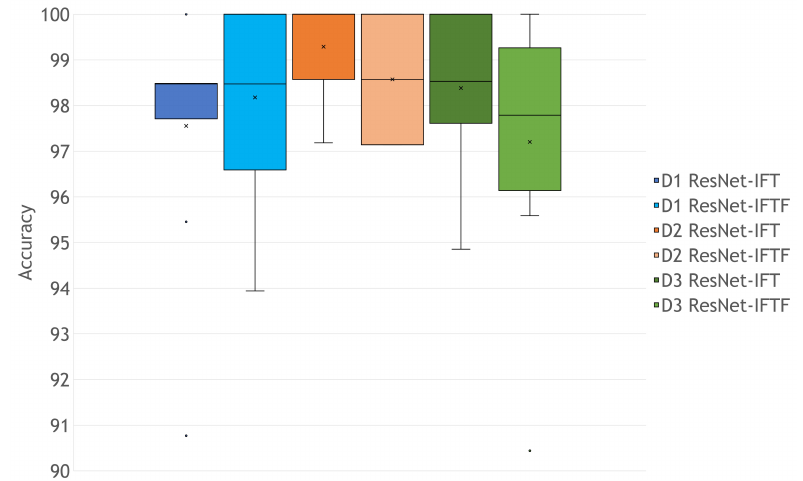
Figure 7. Accuracy analysis for ResNet-IFT and ResNet-IFTF. The quartile calculation used exclusive median; the x symbol shows the mean values.